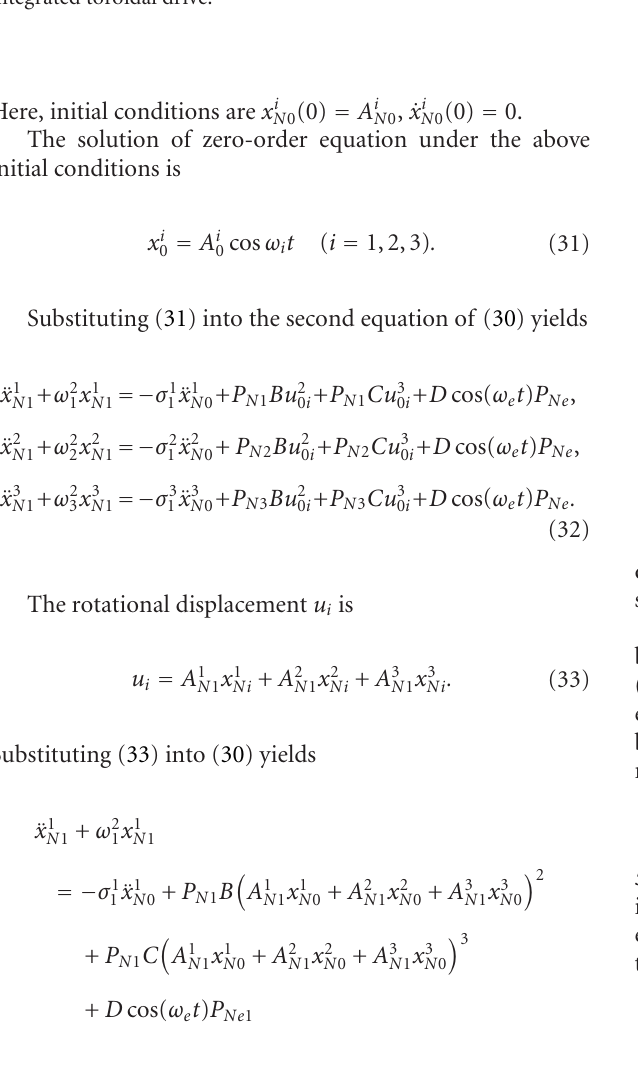
Figure 3: Dynamic model for a four-planet electromechanical integrated toroidal